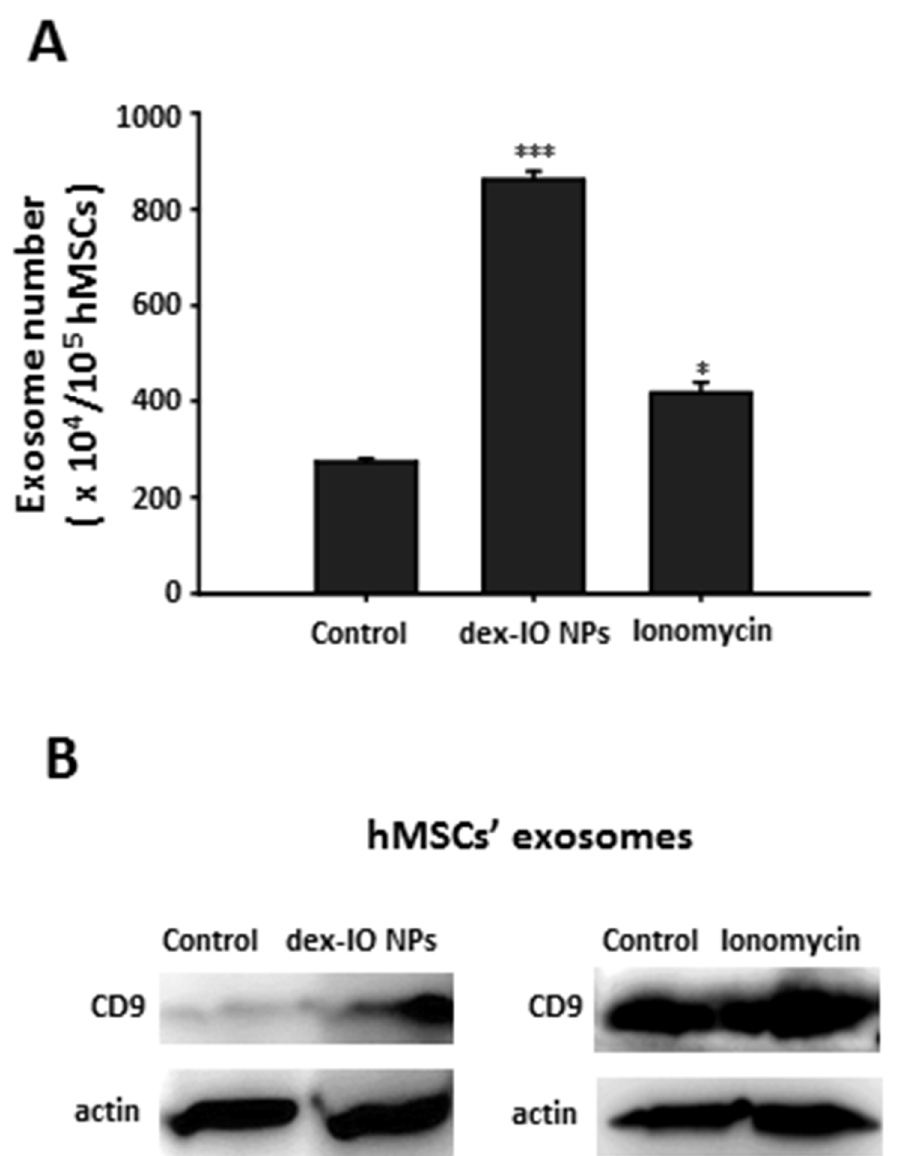
Figure 1. Effects of dex-IO NPs and ionomycin on hMSC’s exosome production and exosomal CD9 expression. ( A ) 1 × 10 5 hMSCs were treated without (Control) or with dex-IO NPs for 1 h or ionomycin for 30 min followed by wash, and then exosomes released from hMSCs for 24 h were collected and determined by nanoparticle tracking analysis (NTA). Data are presented as the mean ± SEM of three independent experiments. * p < 0.05; *** p < 0.001 as compared with Control. ( B ) After treatment of hMSCs without (Control) or with dex-IO NPs for 1 h or ionomycin for 30 min, followed by wash, the exosomes released from hMSCs for 24 h were collected and analyzed by Western blot for exosomal marker CD9. Actin was used as a loading control. Data are representative of at least three independent experiments with similar results.